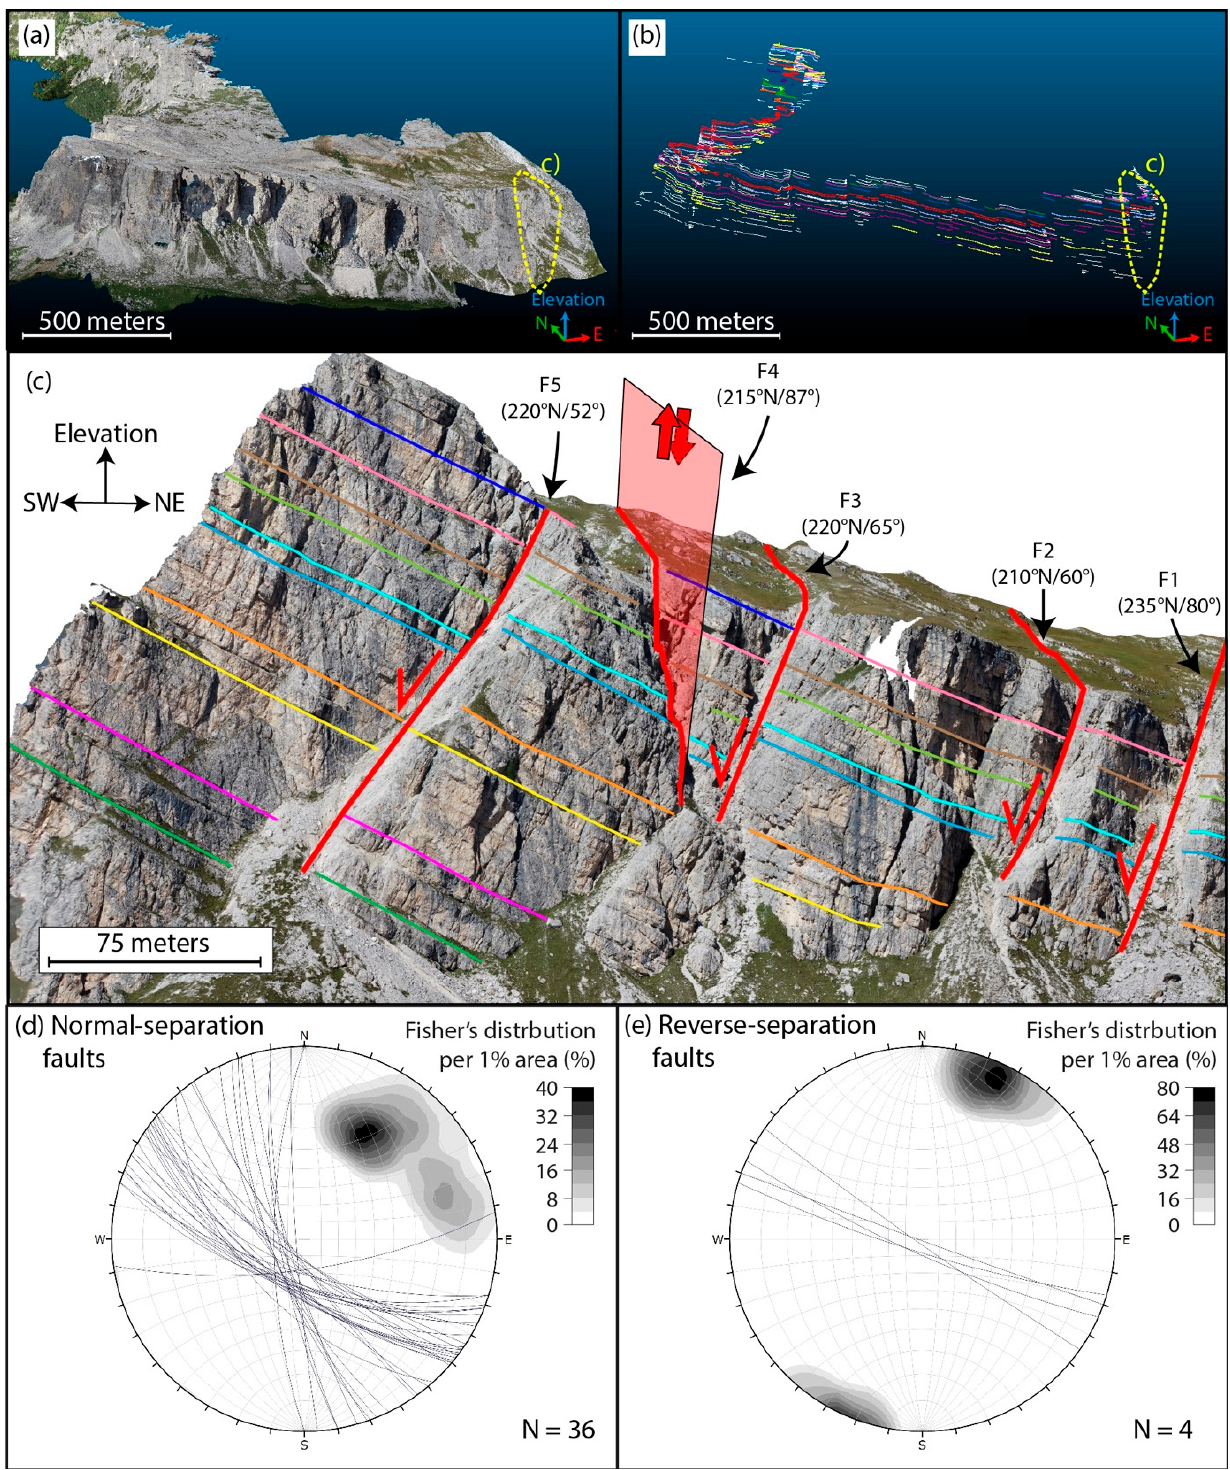
Figure 11. ( a ) Bird’s eye view toward NE of the 3D DOM and ( b ) 3D line ‐ drawing of the visible stratigraphic horizons. ( c ) Horizontal and orthographic view toward NW of the 3D DOM where the faults and the strata are highlighted (see Figure 5b for the fault location). F1, F2, F3, and F5 show normal stratigraphic separation, whereas F4 shows an inverse separation. ( d ) Normal ‐ and ( e ) reverse ‐ separation faults stereographic projection (lower hemisphere equal).